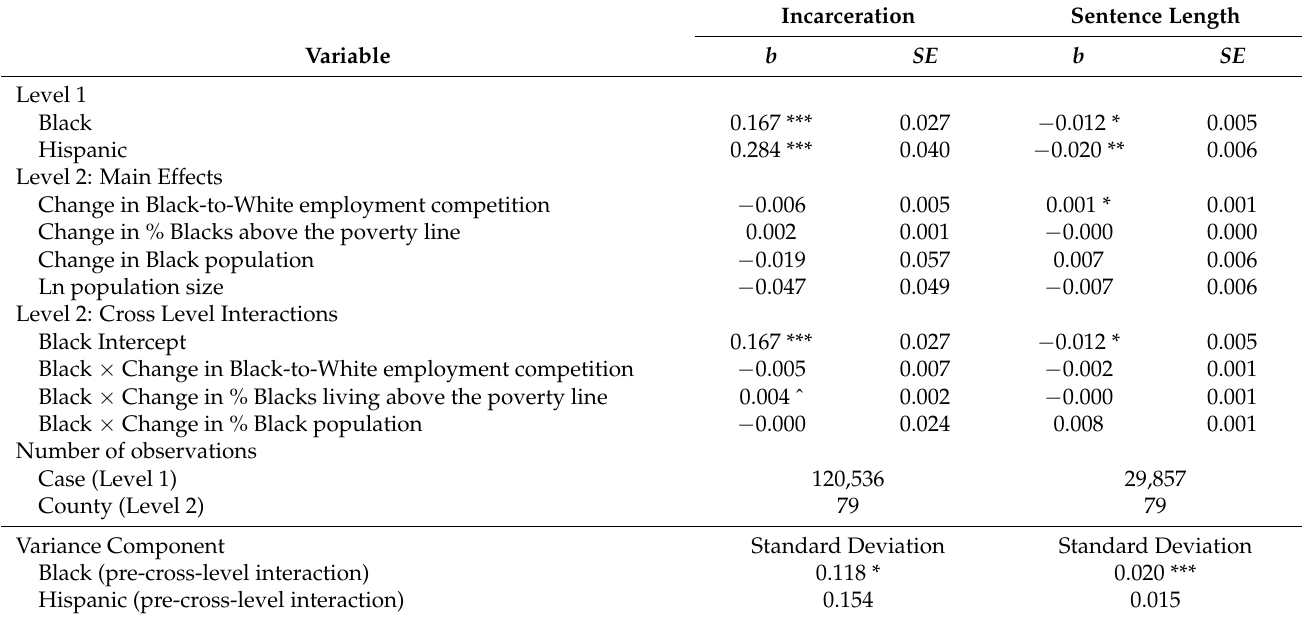
Table 4. Hierarchical Regression Model of Incarceration and Sentence Length, Case-Level, County-Level Effects, and Cross-Level Interactions for Black Threat.